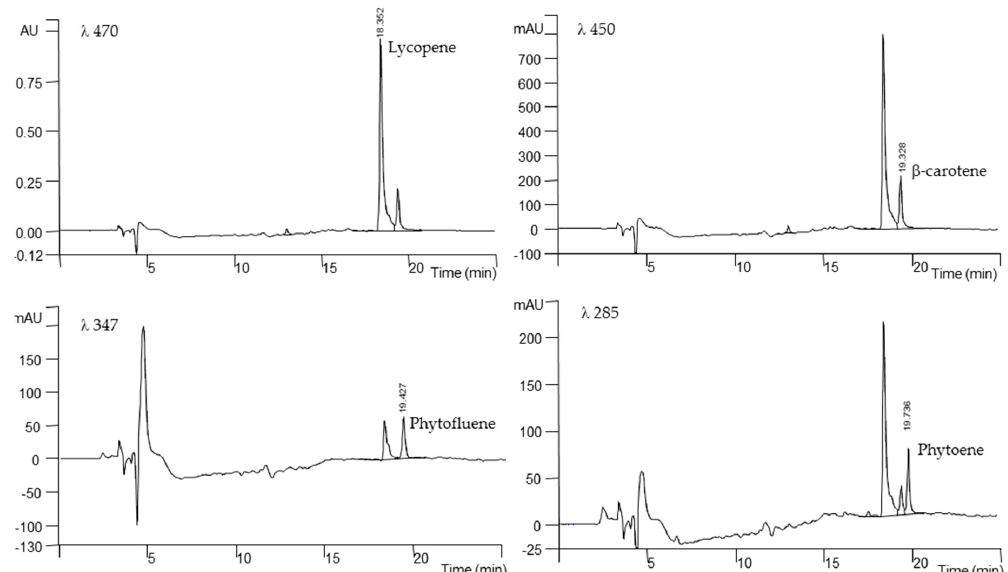
Figure 2. HPLC profile of carotenoids extracted from cherry tomato ‘Sugarland’ at harvest date (S